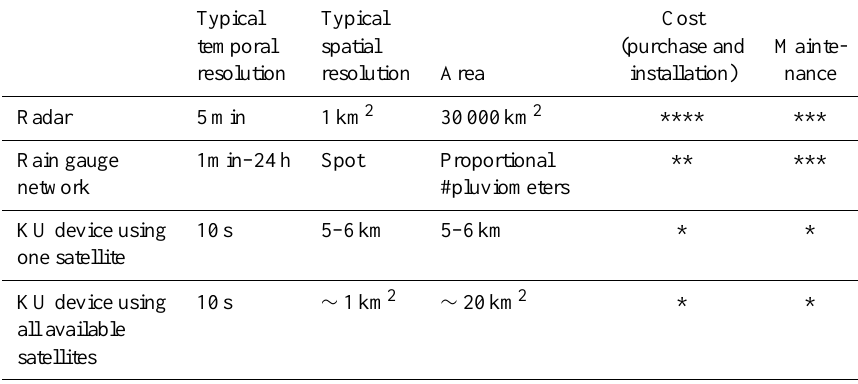
Table 1. Main characteristics of weather radars, rain gauge networks and the Ku device. Typical Typical Cost temporal spatial (purchase and Mainte- resolution resolution Area installation) nance Radar 5min 1km 2 30000km 2 **** *** Rain gauge 1min–24h Spot network